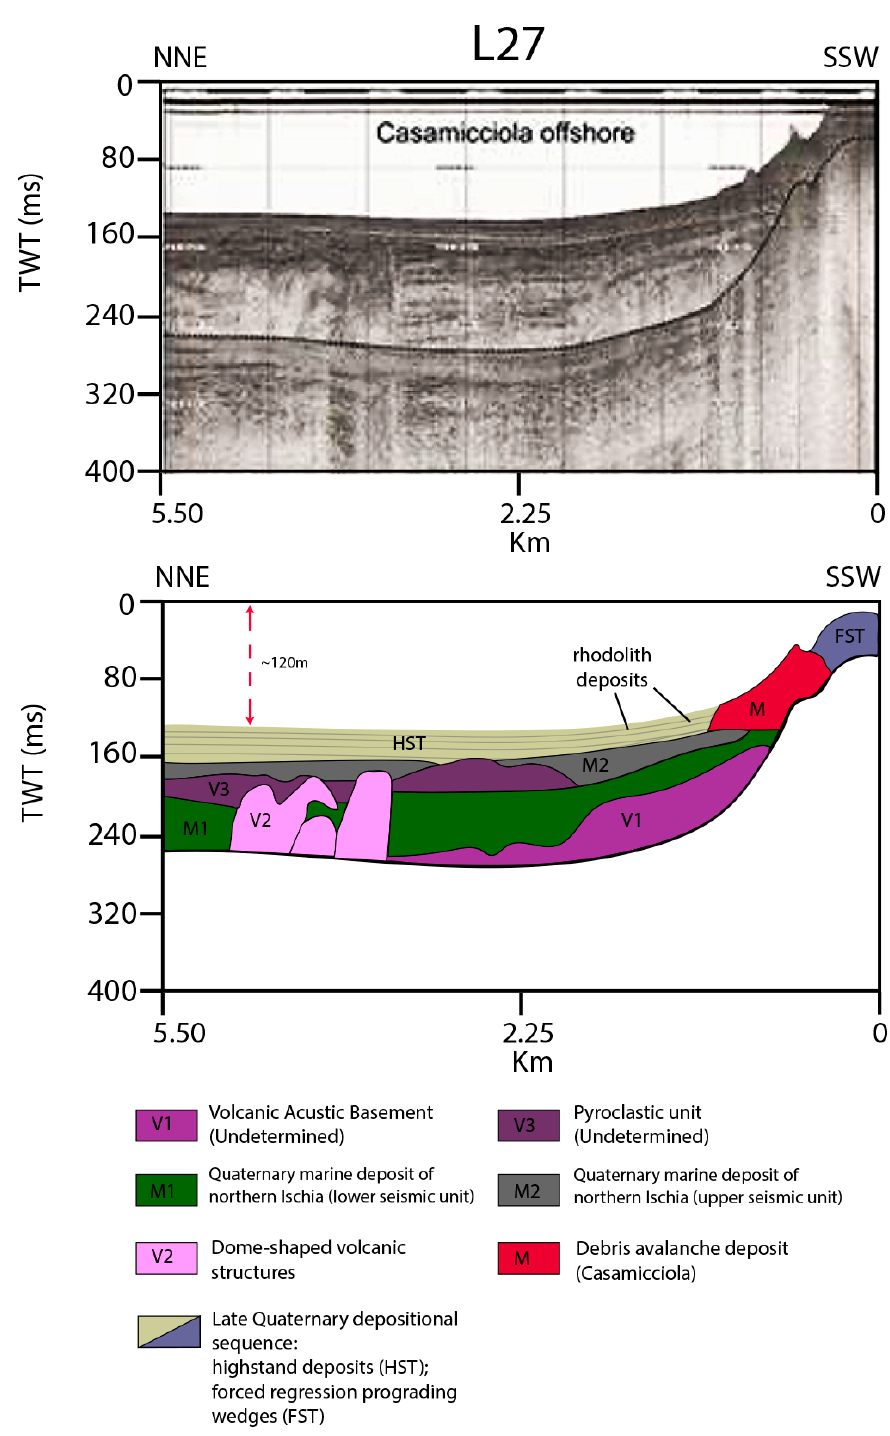
Figure 7. Seismic profile L27 and corresponding geologic interpretation (offshore Casamicciola).